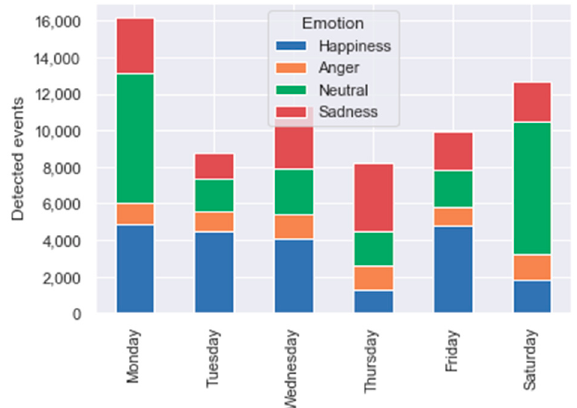
Figure 8. Emotion identification of the high arousal and high valence (HA / HV), high arousal and low valence (HA / LV), low arousal and low valence (LA / LV), and low arousal and high valence (LA / LV) states week 2. Table 3. Overall results per day and per week; results by emotion to the day and the week (week 1). Emotion